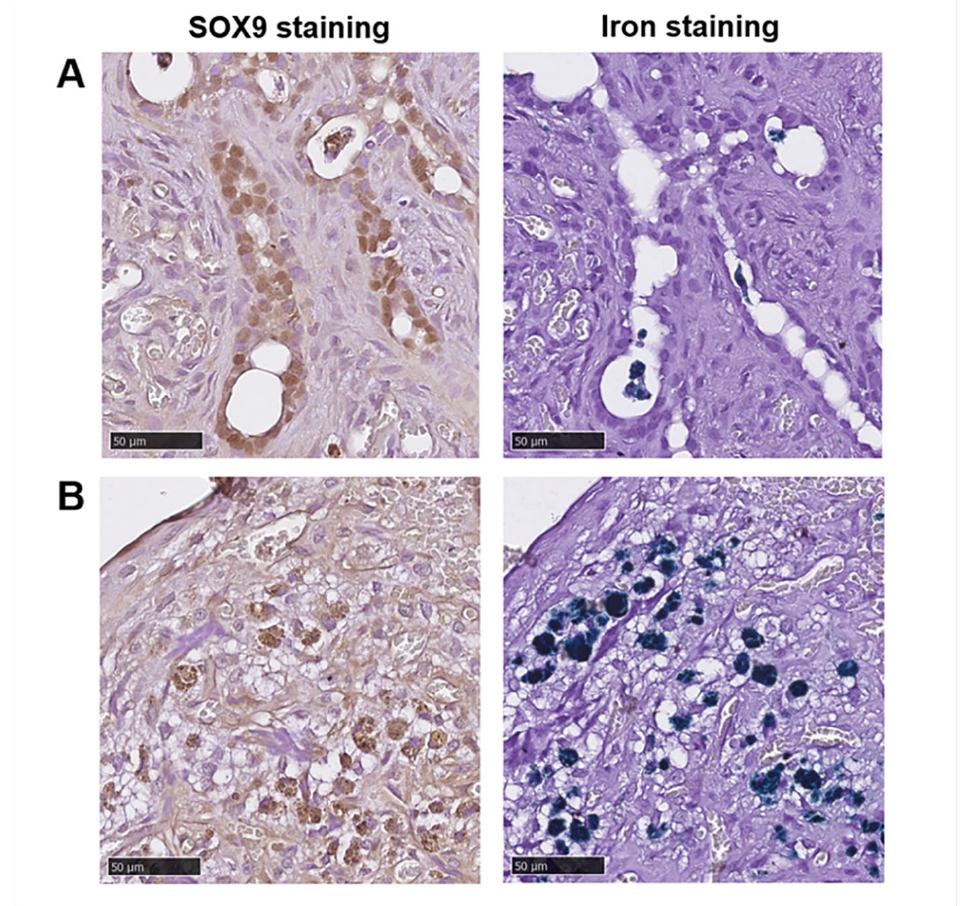
Figure 6. SOX9 and Prussian blue staining of MnMEIO ‐ Ex4 NP ‐ labeled NPCC grafts removed at 51 days after transplantation. ( A ) SOX9 ‐ positive cells (left panel, brown color) around ducts were not stained with iron (right panel). ( B ) Cells with colocalization of SOX9 (left panel, brown color) and iron (right panel, blue color).